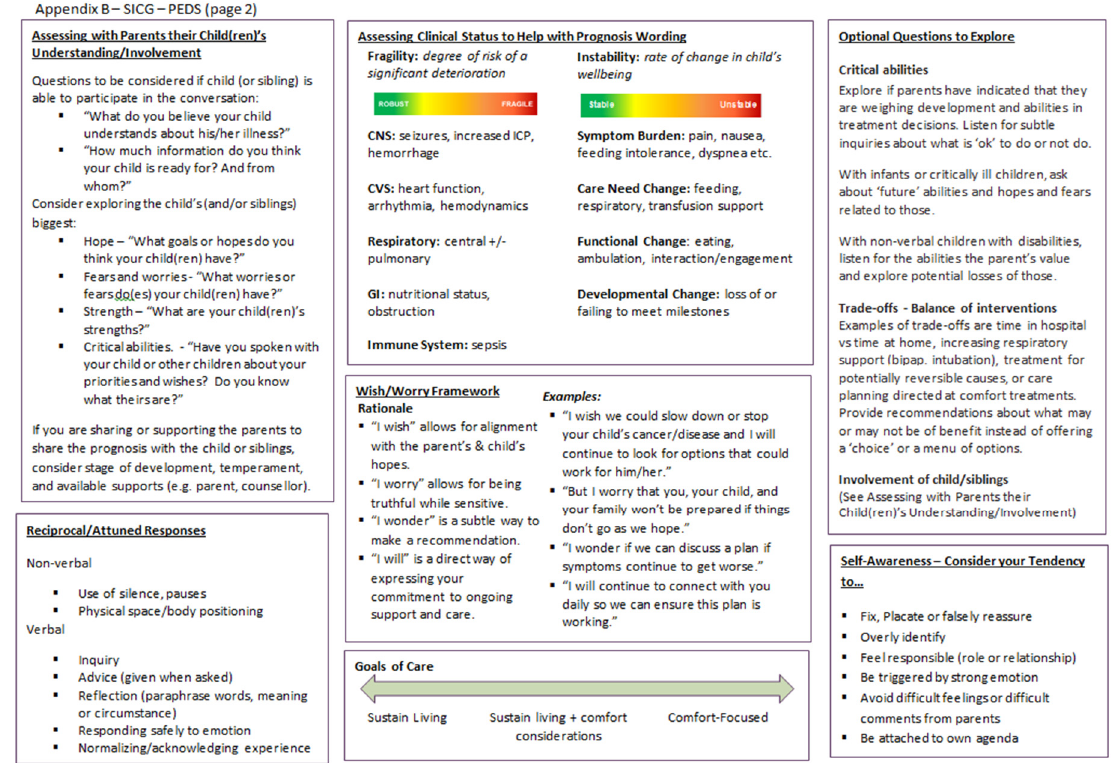
Figure A1. Serious Illness Conversation Guide–PEDS